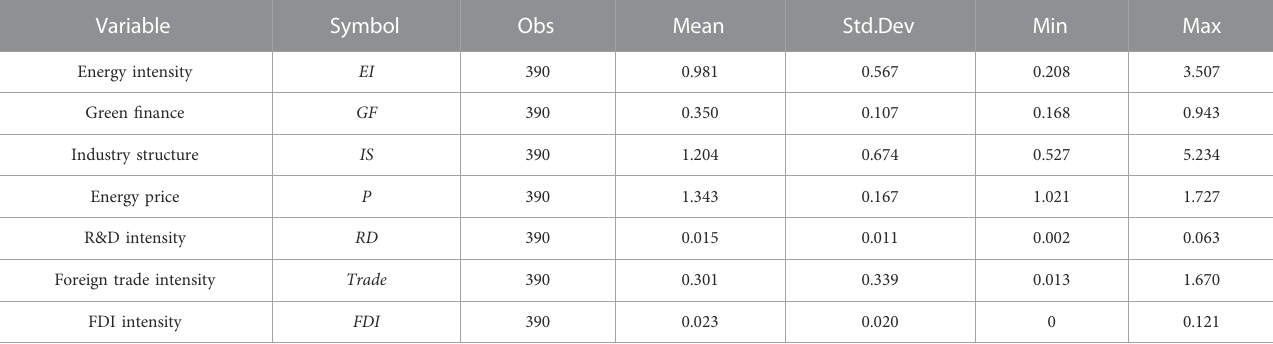
TABLE 1 Descriptive statistics of variables.